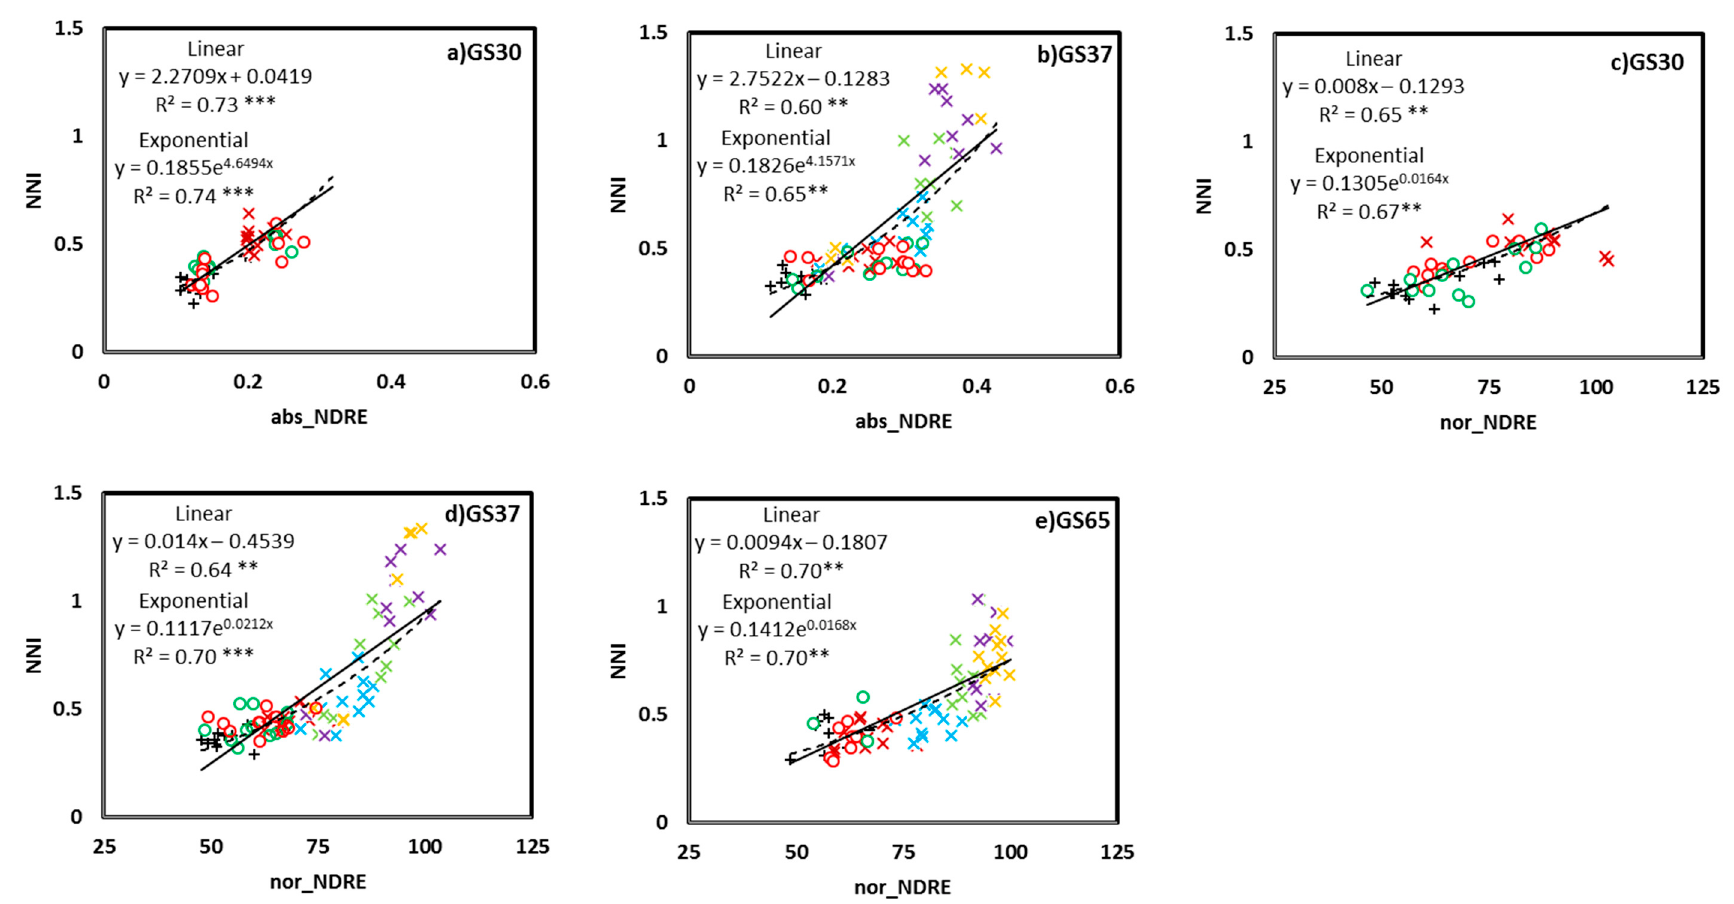
Figure 3. Relationship between the NNI (Nitrogen Nutritional Index) and abs_NDRE values at GS30 ( a ) and GS37 ( b ) and between the NNI and nor_NDRE values at GS30 ( c ), GS37 ( d ), and GS65 ( e ). Two models were fitted: linear, solid line; exponential, dashed line. **, *** Significant at 0.01 and 0.001 probability levels, respectively. + , 0N; × , 40N + 0N; × , 40N + 40N; × , 40N + 80N; × , 40N + 120N; × , 40N + 160N; o, DS + 0N; o, SM + 0N. abs, absolute values; nor, normalized values; NDRE, Normalized Difference Red Edge Index.